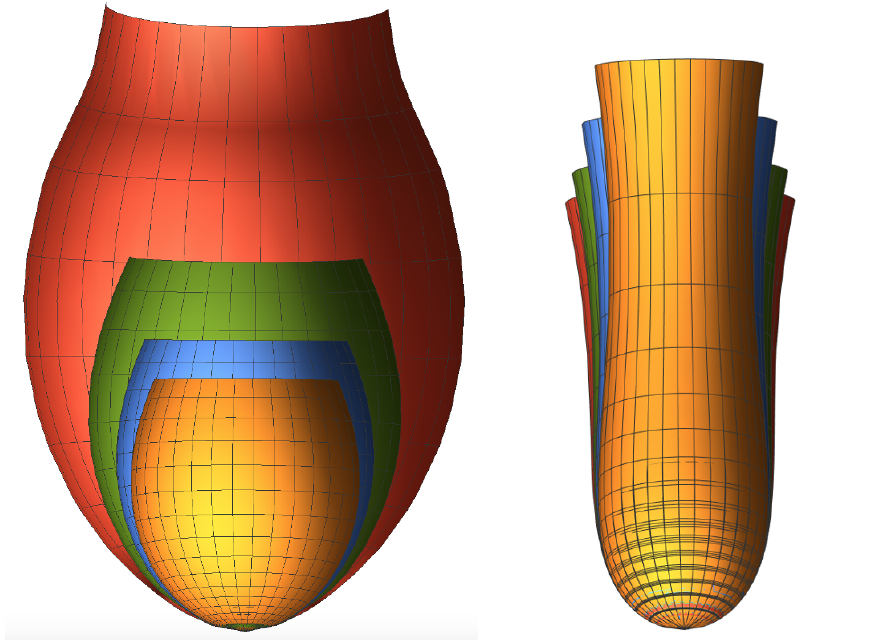
The left (cid:12)gure shows the tip of the boundary geometries of region D4 embedded in Euclidean space for a (cid:12)xed value of (cid:22) = 13 for the following values: (cid:23) = 6 : 7 (yellow), (cid:23) = 6 : 45 (blue), (cid:23) = 6 : 2 (green), (cid:23) = 5 : 98 (red). The red (cid:12)gure is close to the D3-D4 boundary, which is p located at (cid:23) = (cid:22) (cid:0) 2 (cid:22) ’ 5 : 79. The right (cid:12)gure shows the tip of the associated horizon geometry. One can see that, while the change in the boundary is large approaching the boundary D3-D4, the associated change in the horizon geometry is very small. The geometries all approach a unit hyperboloid at